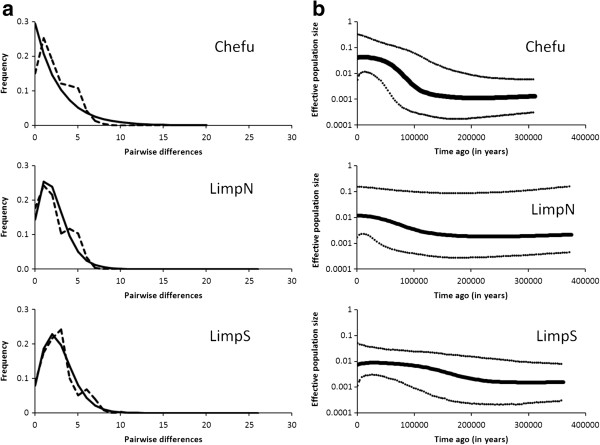
Mismatch distribution and Bayesian skyline plots for the three mtDNA clades. (a) Mismatch distribution between mtDNA haplotypes from three major mtDNA clades. Dashed lines connect observed values and solid lines show the expected distribution under a demographic expansion model. (b) Bayesian skyline plots for the three main clades, showing changes in effective population size (Nem; on a log10 scale) over time (in years). The thick solid line depicts the median estimate, while dotted lines represent the 95% highest posterior density intervals.